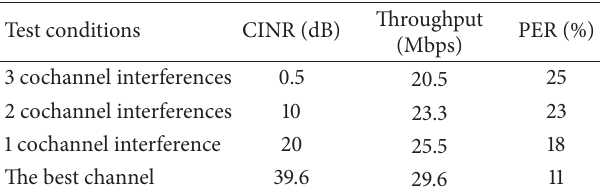
Figure11:Throughputmeasurementasafunctionofthefiberlength for the two frequency bands. Table 3: Performance evaluation considering different levels of cochannel interference in the 2.4 GHz band.